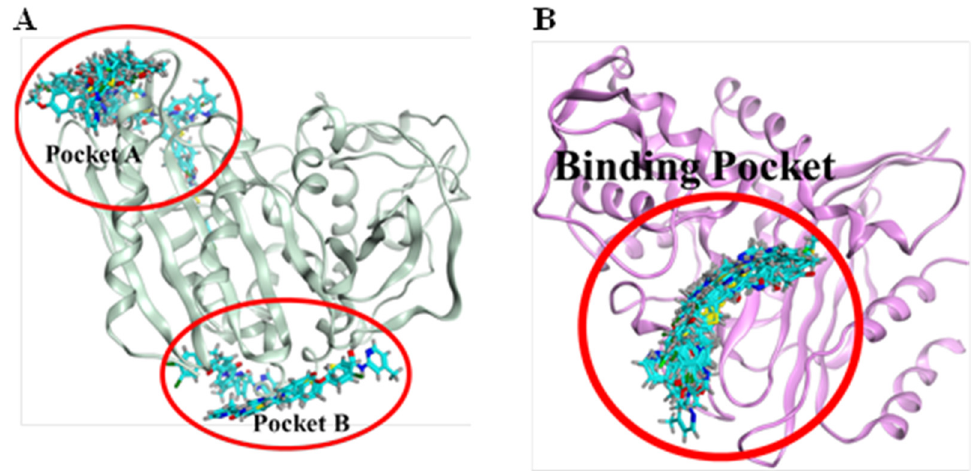
Figure 6. Binding pockets of two target receptors, 6N6K and 7BDS. ( A ): 6N6K represents two binding pockets (pocket A and pocket B). Based on the consensus of confirmations, pocket A was selected for protein-ligand interaction analysis. ( B ): 7BDS demonstrates only one binding region as all of the confirmations of chemical compounds bind in similar regions.